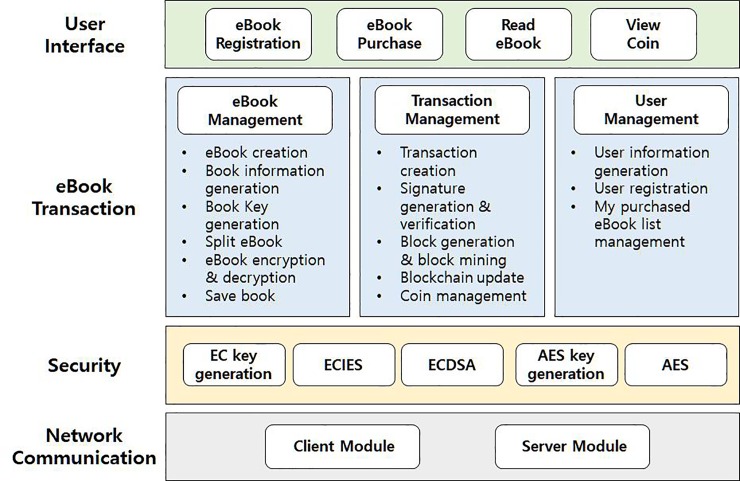
The configuration of a service application.